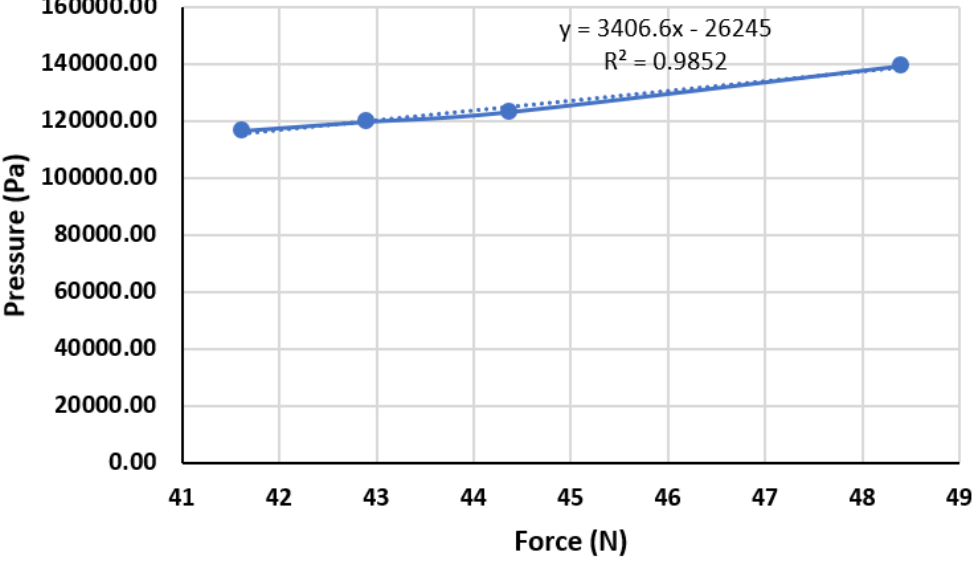
Figure 9. The effect of pressure on force exerted on the leading edge of wing.